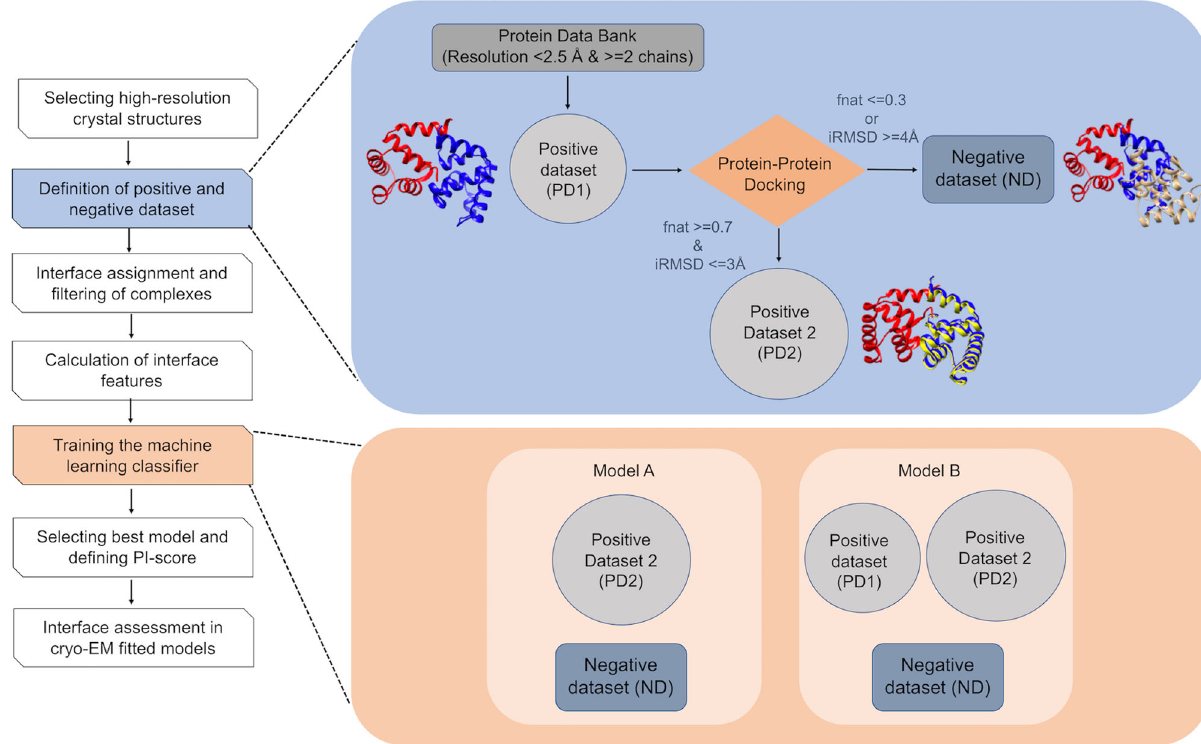
Fig. 1 Work fl ow for developing a protein – protein interface-based score (PI-score) to assess macromolecular assemblies derived using cryo-EM. High resolution complexes (with > = two chains) were obtained from the PDB and are referred to as the ‘ positive dataset 1 ’ (PD1). Protein – protein docking was used to derive structurally close (to PD1) complexes that form the ‘ positive dataset 2 ’ (PD2). The complexes obtained upon docking that have a higher interface RMSD (iRMSD) and lower fraction of aligned native residues (f Nal ) at the interface form the ‘ negative dataset ’ (ND). Interface features are calculated on all the complexes and are used as an input to train a supervised machine-learning classi fi er, which is further used to predict the class labels of the benchmark